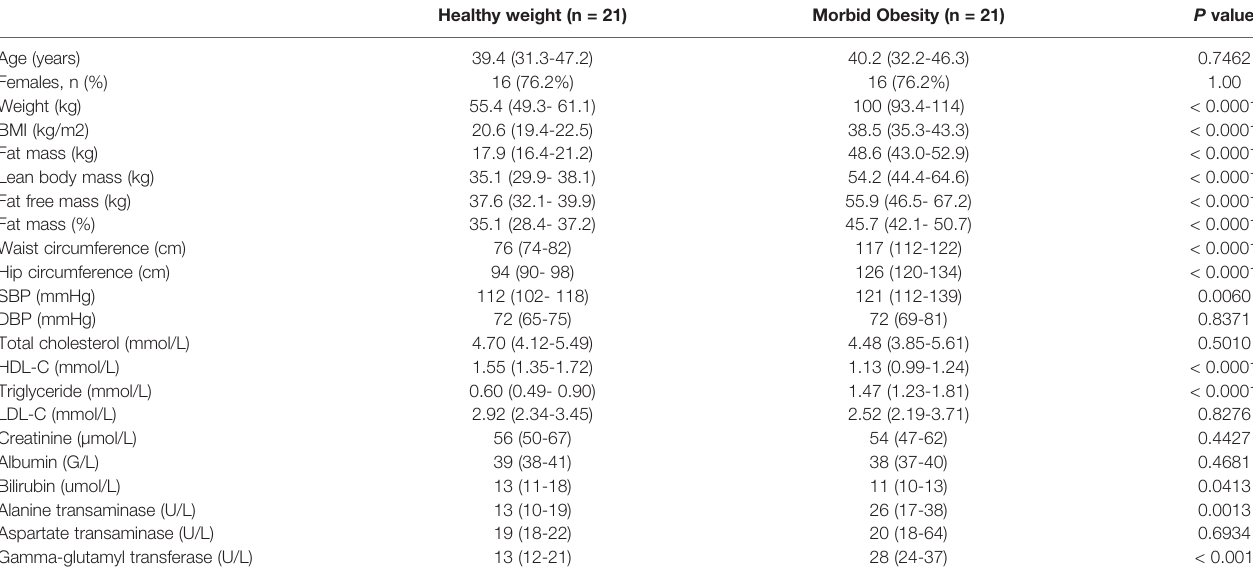
TABLE 1 | Baseline characteristics of participants with healthy weight and with morbid